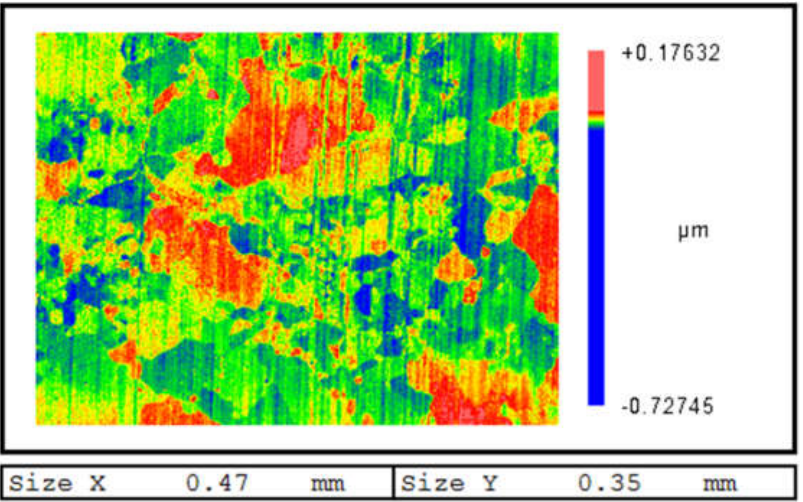
Figure 6. Surface morphology of aluminum with short time IBS.